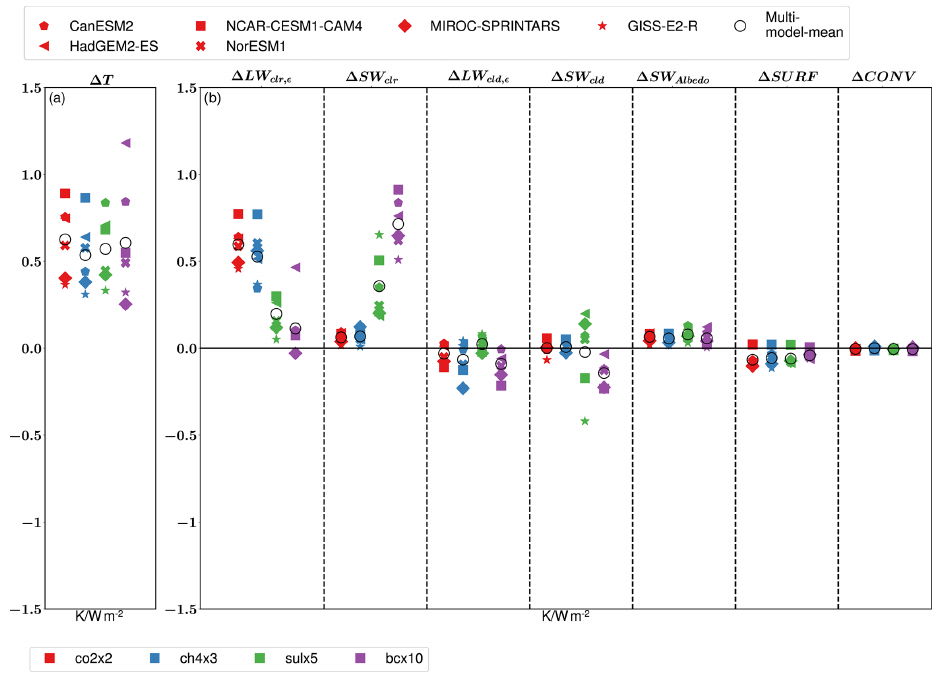
Figure 3. The global mean effective temperature response and its decomposition, calculated as the difference between means over the last 50 years of the perturbed and the baseline experiments. (a) The effective temperature response (absolute temperature response divided by ERF fsst ) for the six models shown with different symbols and four different radiative forcers shown with different colors. (b) The decomposition of the effective temperature response to different energetic components. Individual panels in (b) describe (from the left) the contributions to total effective temperature response due to the change in longwave clear-sky emissivity ( (cid:49) LW clr ,ε ), change in TOA shortwave radiation ( (cid:49) SW clr ), change in longwave cloud emissivity ( (cid:49) LW cld ,ε ), net ocean surface heat flux ( (cid:49) SURF), and change in atmospheric energy transport ( (cid:49)